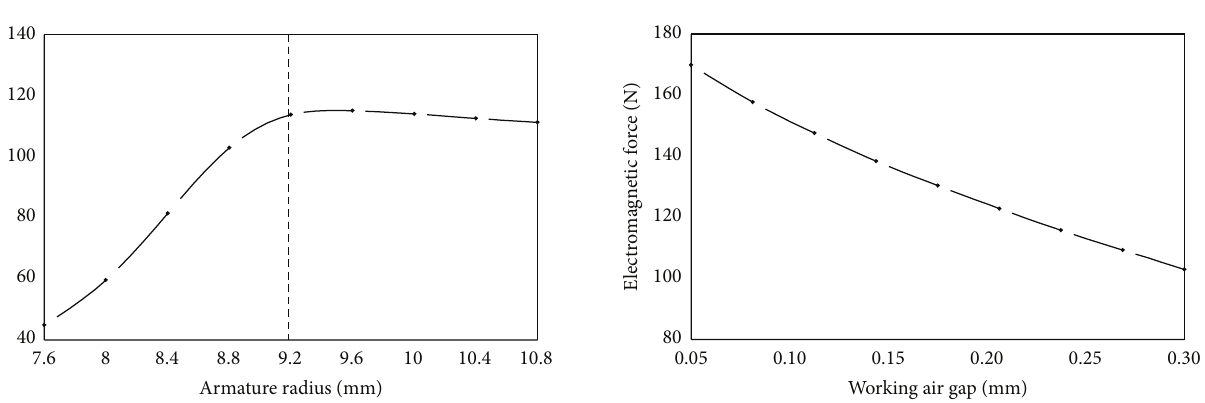
Figure 13: Influence of armature radius on electromagnetic force.